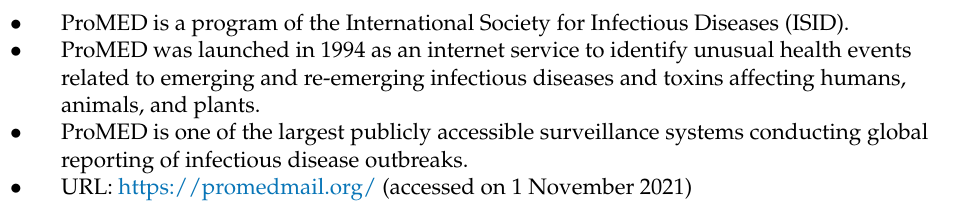
Table 1. Disease Surveillance